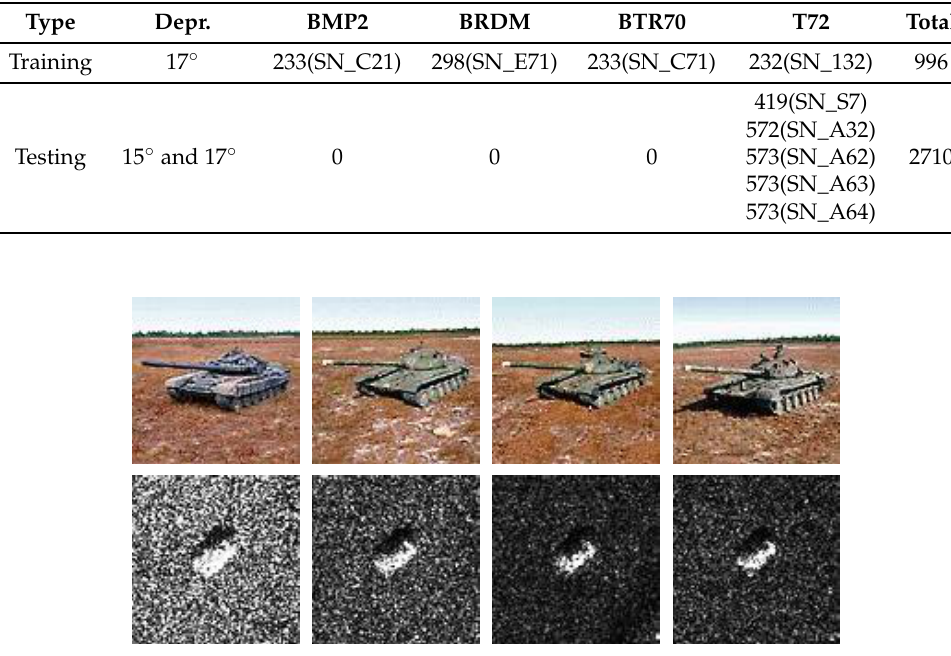
Figure 7. Examples of T72 with different version variations; the optical and SAR images listed from left to right are A32, A62, A63 and